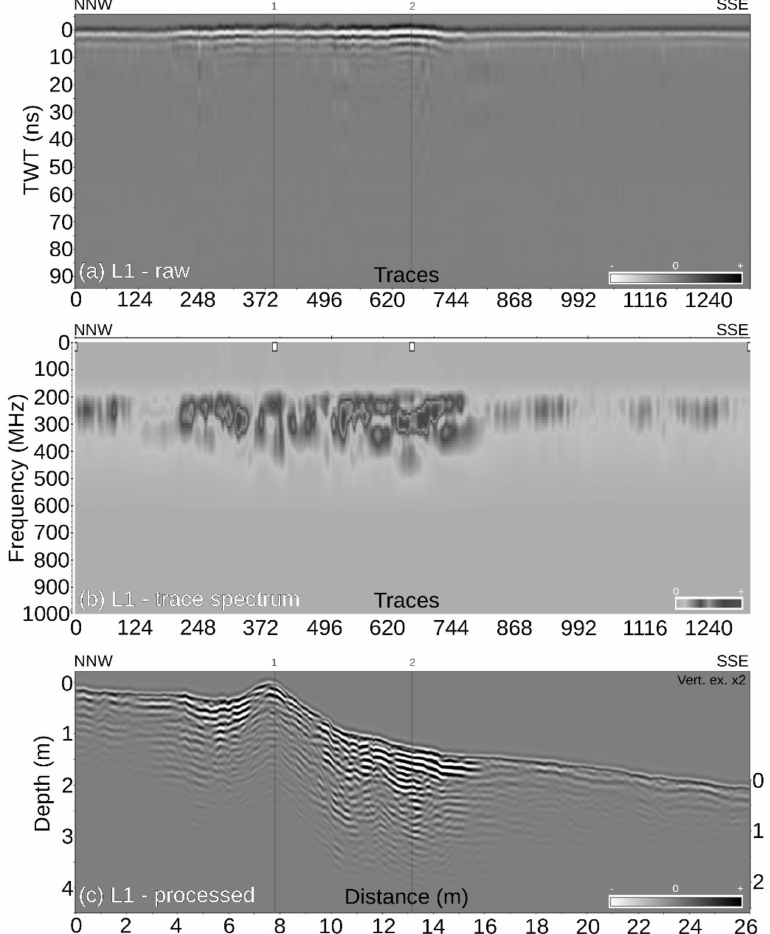
Figure 12. Profile L1 recorded using the 500 MHz antenna at the Bargiano study site; ( a ) raw GPR profile crossing the cololite C14 at ~8 m; ( b ) amplitude spectrum computed for each trace of profile L1 in ( a ), clearly showing the limited frequency content, particularly on the right side, due to strong attenuation; ( c ) processed profile displaying moderate to high reflectivity, particularly the reflections package in the central sector at ~13 m, down to ~1 m depth; note the strong attenuation of reflections within the range 16–26